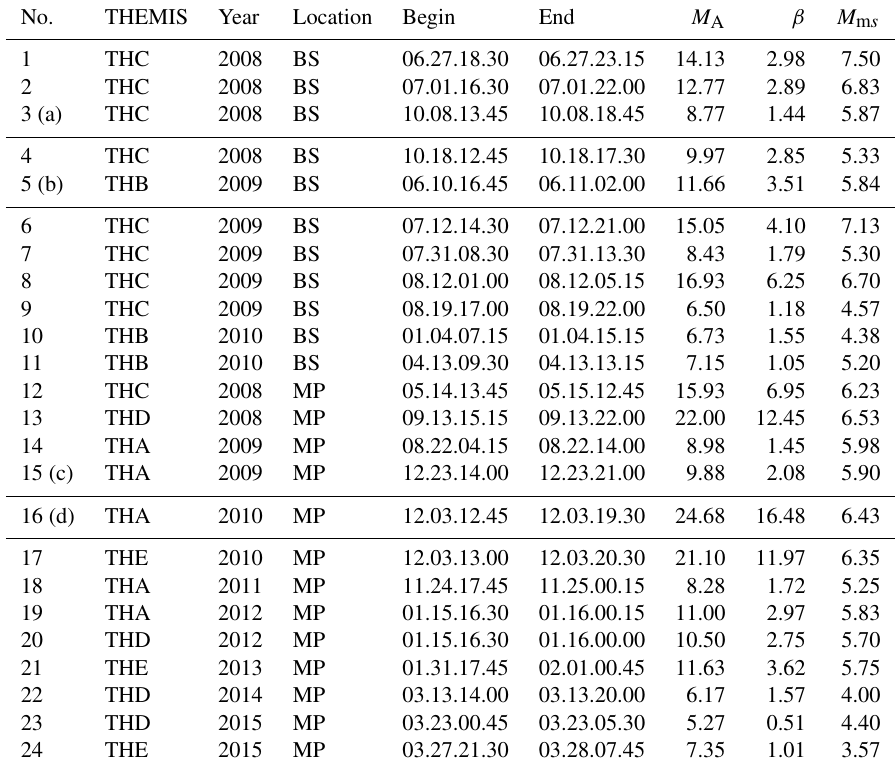
Table 2. List of selected interval samples